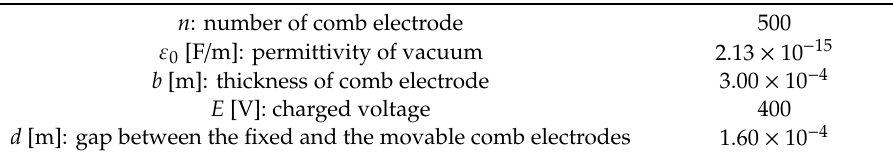
Table 1. Structural and material properties of MEMS vibrational power